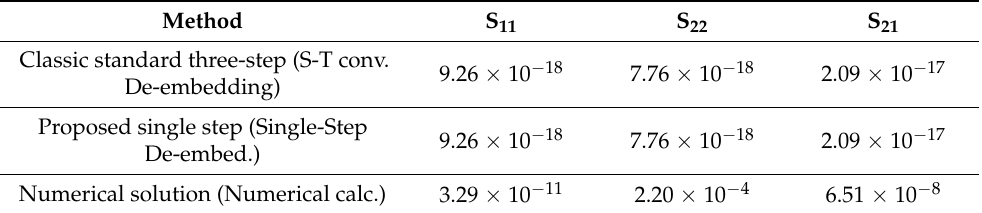
Table 2. Root mean squared difference for the considered de-embedding